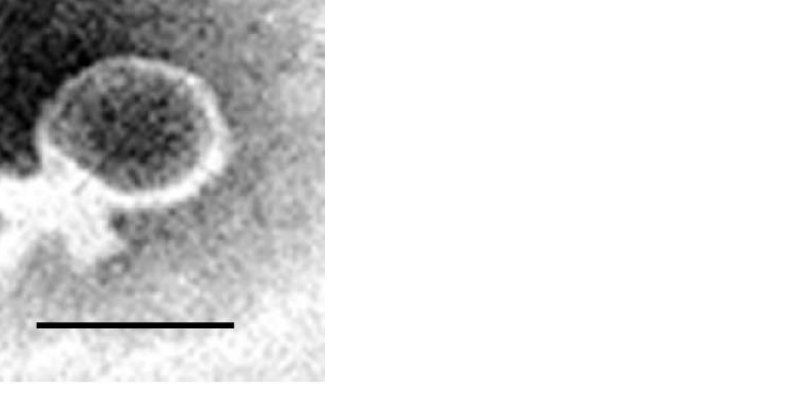
Figure 2. Transmission electron micrograph of phage vB_ZEFP: The phage exhibits a short non-contractile tail indicative of the Podoviridae family. The scale bar represents 50 nm.